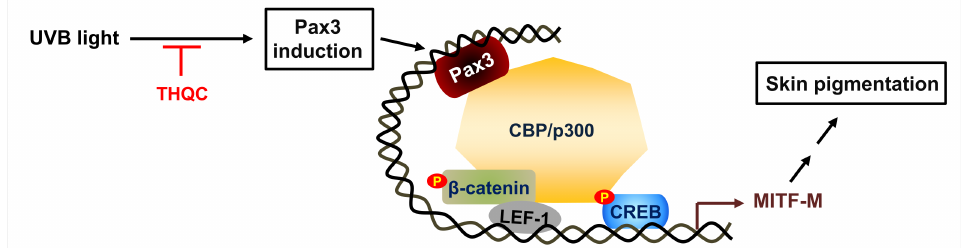
Figure 6. A proposed mechanism of THQC on antimelanogenic activity. Topical treatment with